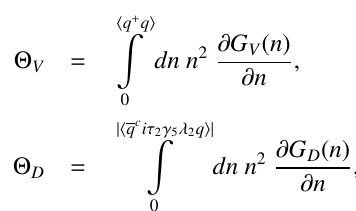
the rearrangement